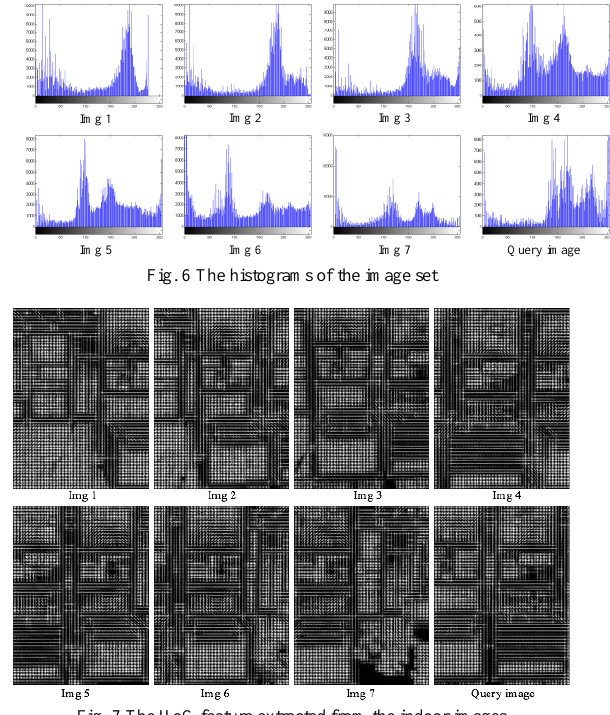
Fig. 7 The HoG feature extracted from the indoor images